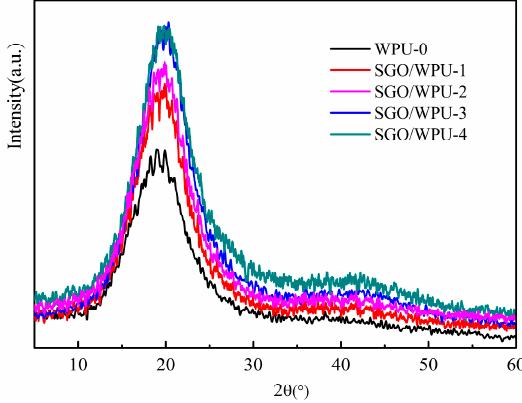
Figure 7. X-ray diffraction spectra of WPU and SGO/WPU.